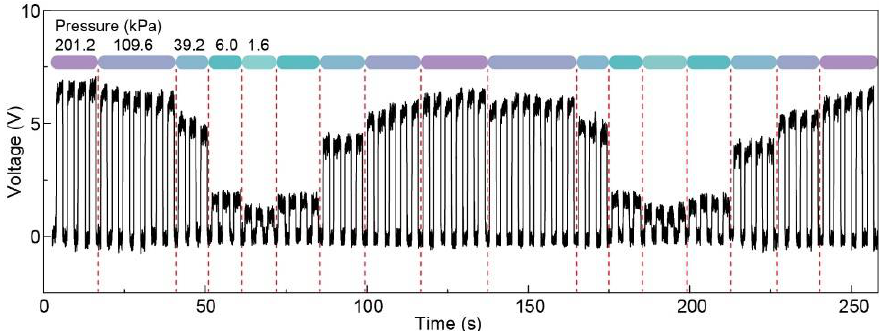
Figure 6. Output voltage under various pressures to show the repeatability of pressure sensing measurement for the patterned Ag NFs electrode based pressure sensor array.